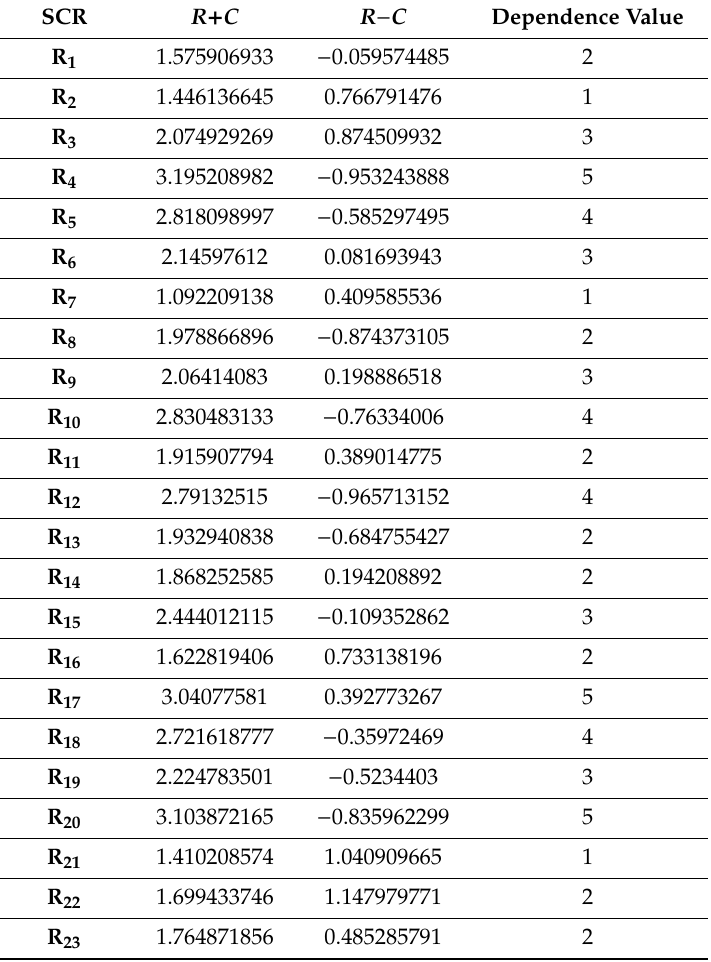
Table 11. Prominence and relation for each risk and evaluation scale of the dependence